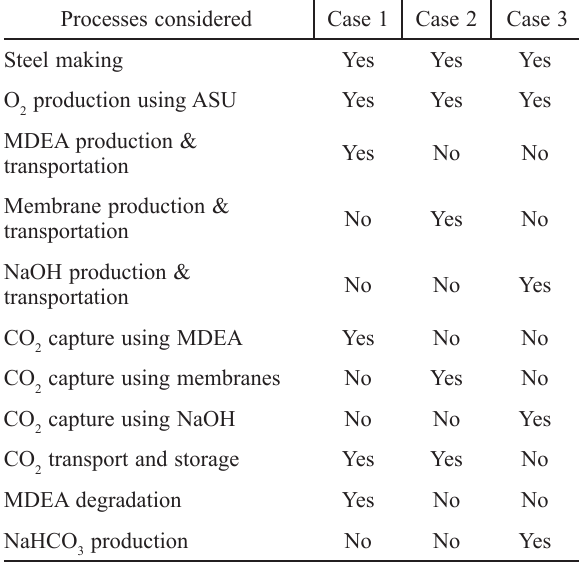
Table 4 – Sub-processes considered in the LCA Processes considered Case 1 Case 2 Case 3 Steel making Yes Yes